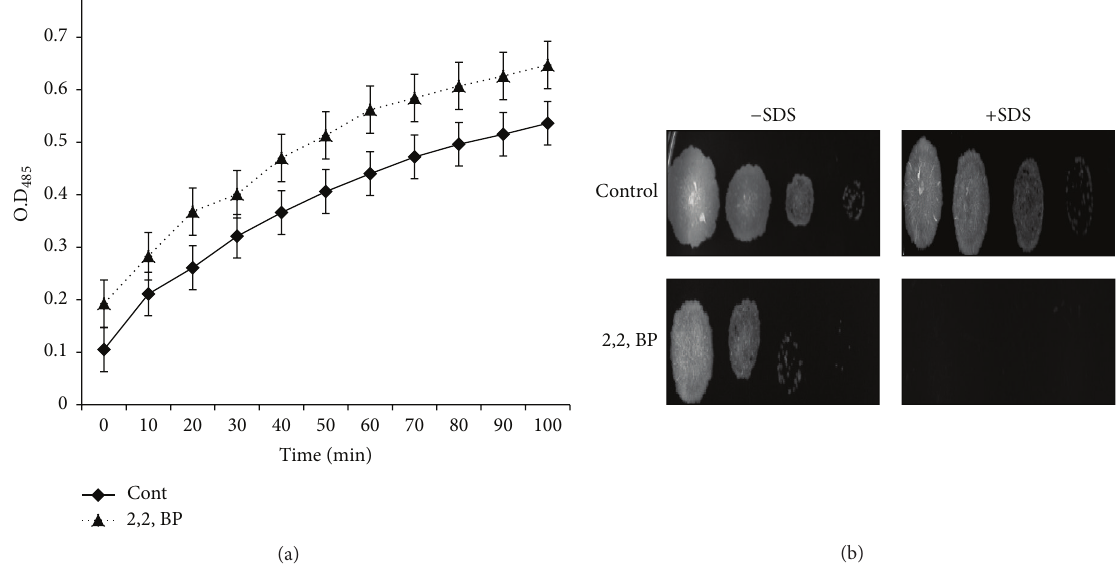
Figure 4: Effect of iron deprivation on cell membrane. (a) Nitrocefin membrane permeability assay for M. smegmatis cells grown in the absence (control) and the presence of 2,2, BP (35 𝜇 g/mL). Means of O.D 485 ± SD of three independent sets of experiments are depicted on 𝑦 -axis with respect to time (minutes) on 𝑥 -axis ( 𝑃 < 0.05 ). (b) Spot assay of M. smegmatis in the absence (control) and the presence of 2,2, BP (35 𝜇 g/mL) and cell membrane perturbing agent (SDS) at